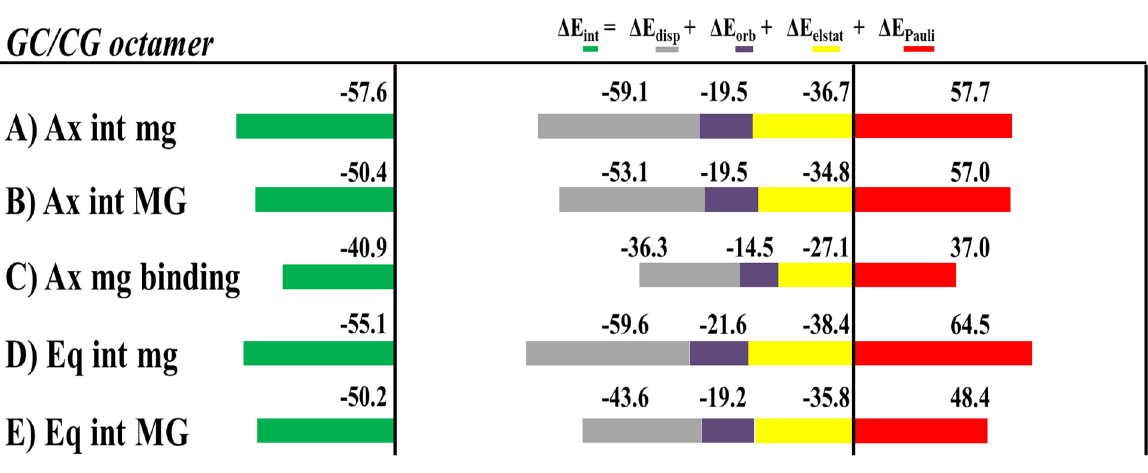
Figure 23. Cumulative bar diagrams for the EDAs associated to the intercalation of [Mo( η 3 -C 3 H 5 )Br(CO) 2 (phen)] with the d(AGACGTCT) 2 octamer of dDNA. For the Ax isomer, the EDA for the groove binding was also considered. Energies at B3LYP-D3/TZP level of theory in kcal mol − 1 . Table 1. Contributions of the solvation energies ( ∆ E Solv ), in kcal mol − 1 , for the most stable modes of interaction of the Eq and Ax isomers of the [Mo( η 3 -C 3 H 5 )Br(CO) 2 (phen)] complex interacting with the d(AGACGTCT) 2 duplex DNA at the B3LYP-D3/TZP level by using the COSMO approach.